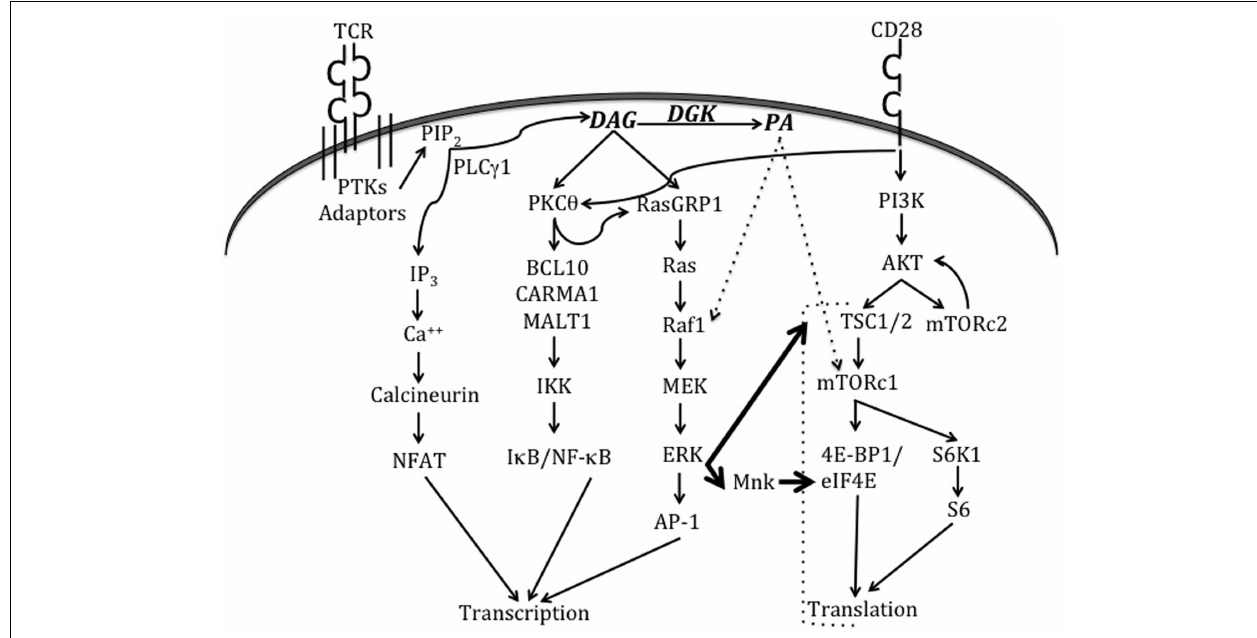
activation of PKC θ and the PI3K-Akt-mTOR axis. Recent work (indicated by thick arrows) has shown thatTCR signaling can also directly activate mTOR complexes via the Ras-ERK pathway, and that such activation is negatively regulated by DGK activity. ERK can also activate Mnk1/2 kinases that phosphorylate eIF4E to promote translation. PA is produced inT cells by the action of both DGKs and PLDs (not shown in this figure). In other cell types, PA has been shown to activate Raf1 and mTORc1. Please refer to the text for more details aboutTCR-triggered signaling pathways and effector molecules that bind to DAG or